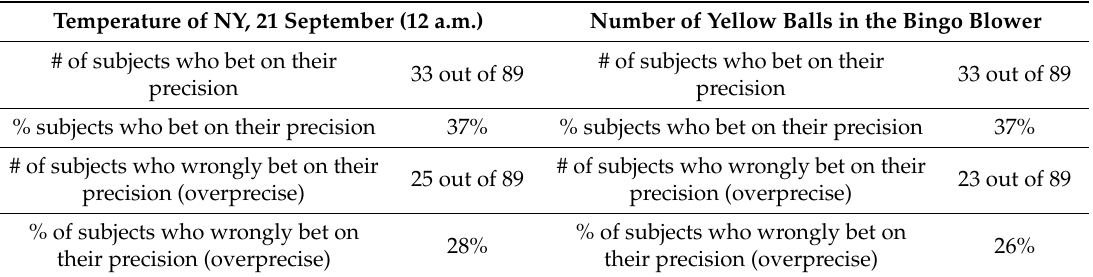
Table 4. The precision and external ambiguity in the Self Selection treatment.